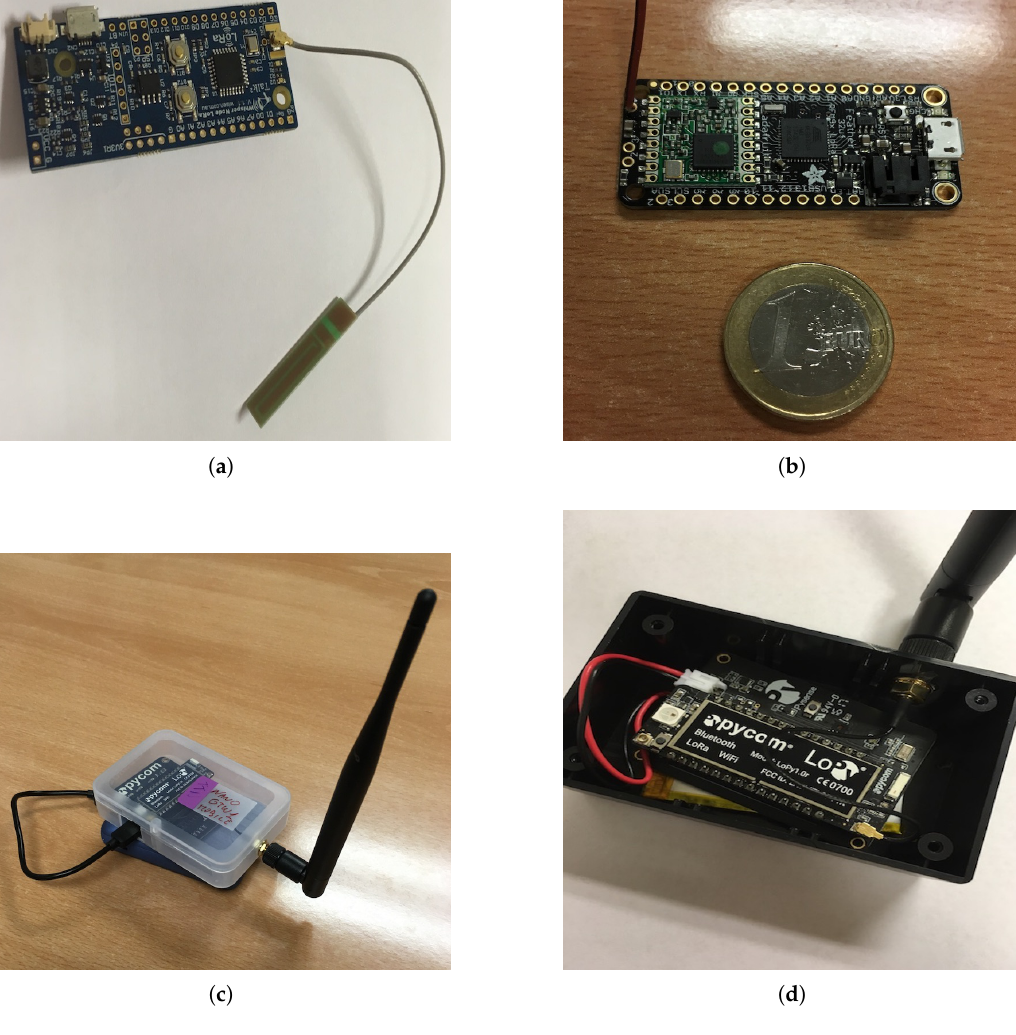
Figure 7. The hardware used for the experiments. On top the two clients used ( a ) a Whisper Node by Wisen, ( b ) an Adafruit Feather 32u4, on bottom ( c , d ) two gateways based on a LoPy by